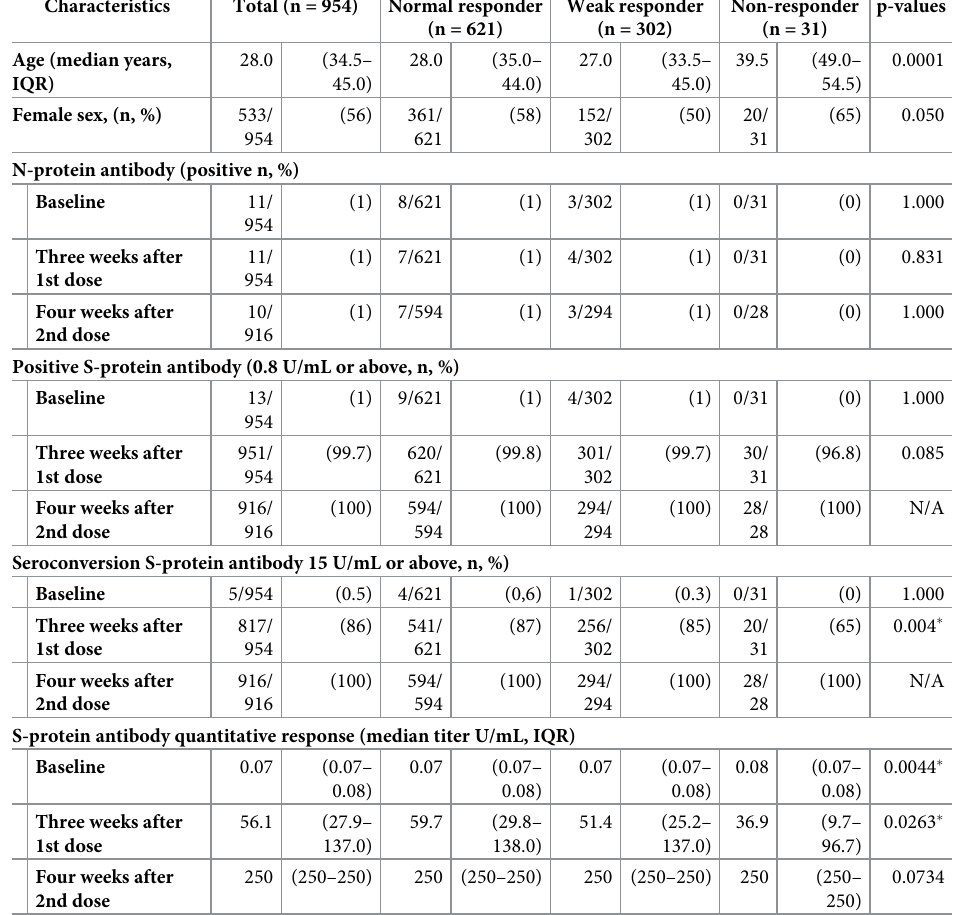
Table 1. Characteristics and SARS-CoV-2 N and S protein antibody status before and after receiving the BNT162b2 mRNA-1273 COVID-19 vaccine among healthcare workers in the study (n = 954). Characteristics Total (n = 954)